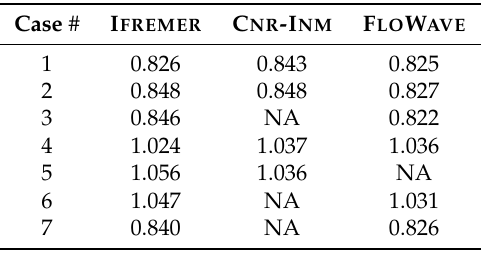
Table 4. U ∞ expressed in m/s and processed with the disc-integrated method from ADV measurements carried out without the turbine. Case